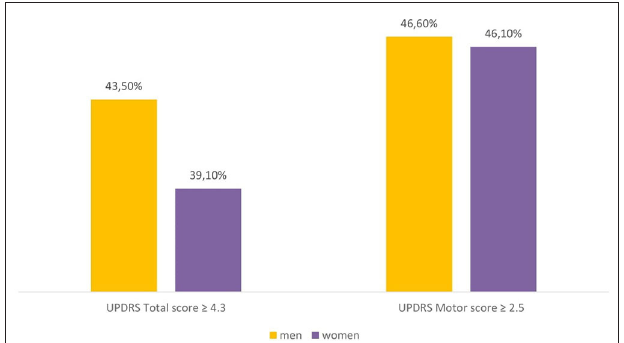
FIGURE 3 | Percentage of male and female patients with clinically important difference (improvement) in the UPDRS scores (difference between 12-months follow-up and baseline). UPDRS, Unified Parkinson’s Disease Rating